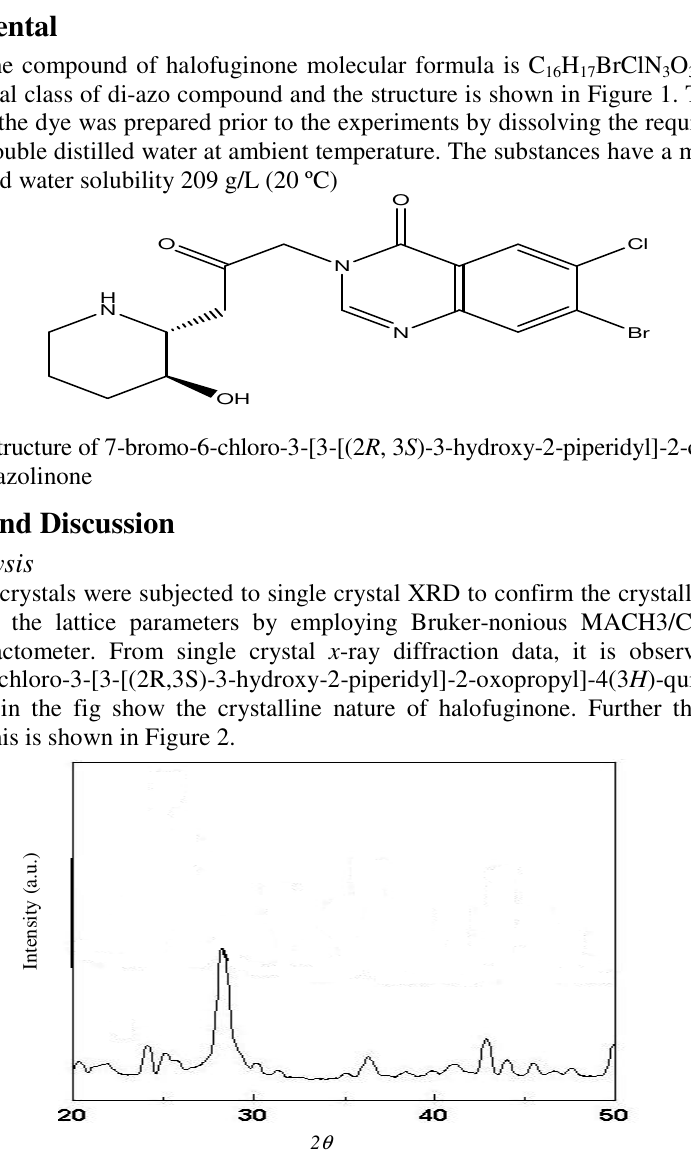
Figure 2. XRD patterns recorded from 7-bromo-6-chloro-3-[3-[(2 R ,3 S )-3-hydroxy-2- piperidyl]-2-oxopropyl]-4(3 H